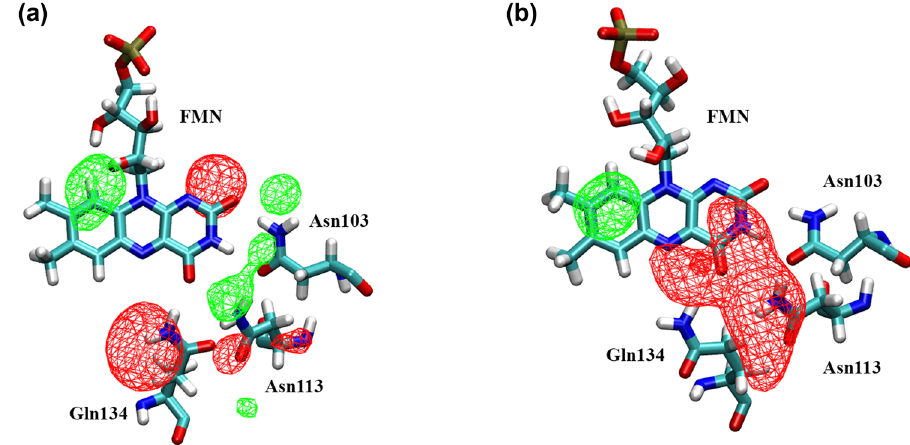
Figure 7: Occupancy volume maps of oxygen ( red, isosurface value 5% ) and water ( green, isosurface value 25% ) in the binding pocket of C71S - Y61T ( a ) and of C71S - Y61S ( b ) variants ( replica C71S - Y61T_oxy_r1 and C71S - Y61S_oxy_r1 are shown as an example ) . The volume maps were averaged on the whole trajectory after skipping the fi rst 5 ns. A neighbourhood of 8 Å around atom O4 of FMN cofactor includes the whole binding pocket. The FMN and the HB networking triad are shown as a